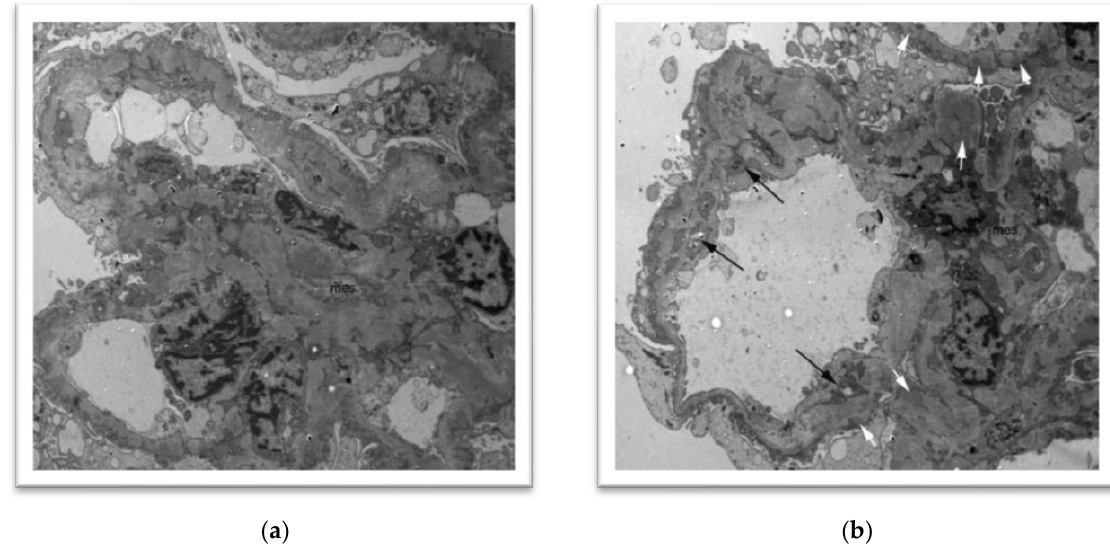
Figure 3. Renal biopsy ( a ) showing “Immune complex-mediated glomerulonephritis with mesangial deposits suggestive for membranous/membranoproliferative glomerulonephritis type III” ( b ); black and white arrows.